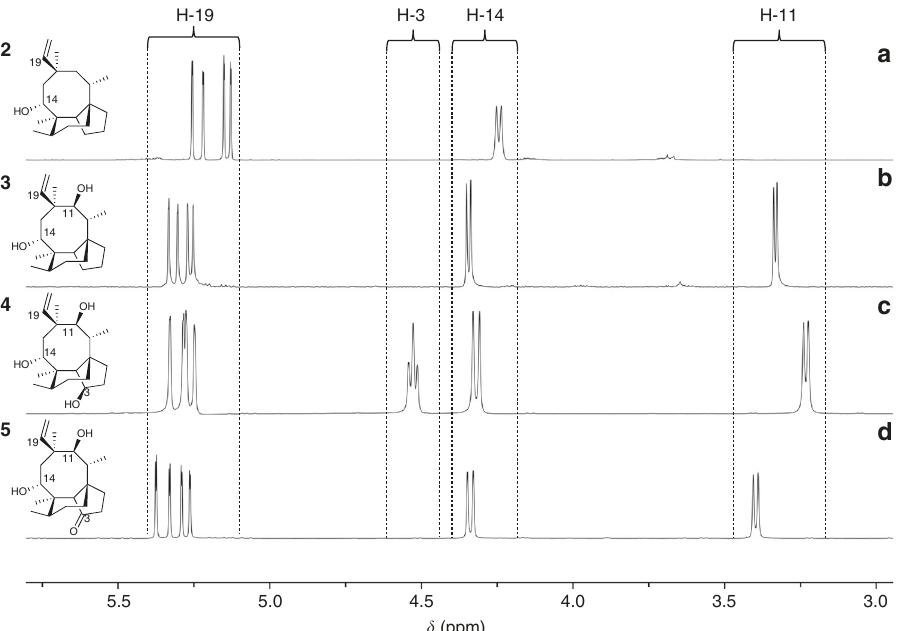
Fig. 3 1 H-NMR spectra of selected biosynthetic intermediates. The region δ 3.0 – δ 5.5 ppm is shown for a 14-alcohol ( 2 ), b 11,14-diol ( 3 ), c 3,11,14-triol ( 4 ) and d mutilin ( 5 ). Data were recorded in CDCl 3 (500